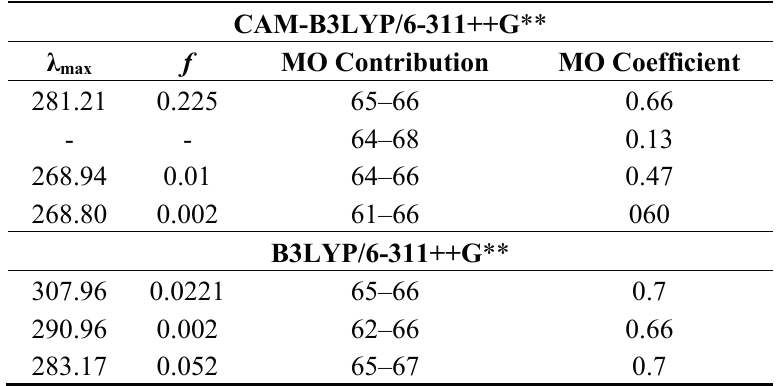
Table 4. TD-DFT spectral data of electronic transitions for 8-OateQ-anti using CAM-B3LYP and B3LYP functionals at 6-311++G** basis